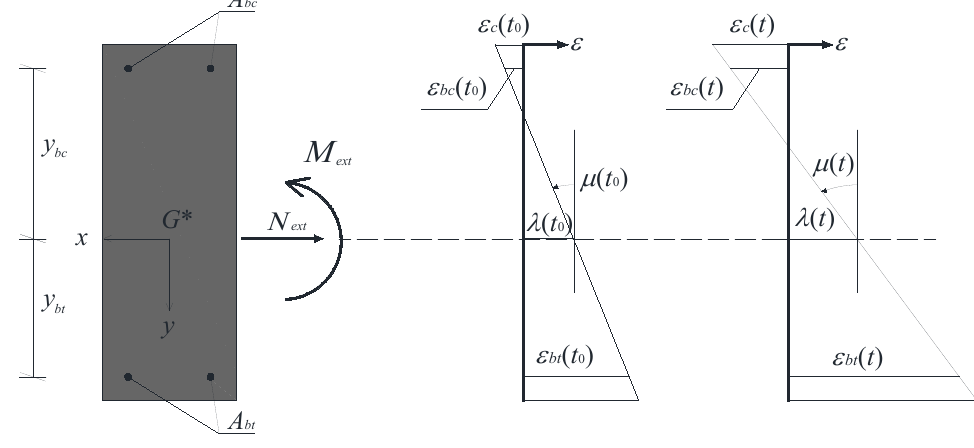
Figure 1. Instantaneous strain and curvature of the